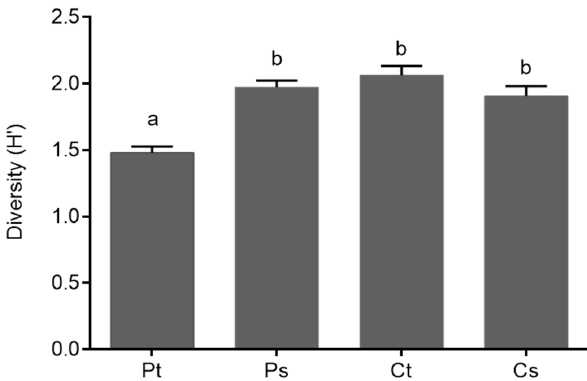
Figure 3. Diversity of nitrogen-fixing bacteria associated with thalli and substrates of Peltigera and Cladonia lichens. Means and standard error are shown. Different letters above the bars represent significant differences (ANOVA-Tukey; p ≤ 0.05). Pt: Peltigera thalli; Ps: Peltigera substrates; Ct: Cladonia thalli; Cs: Cladonia substrates.